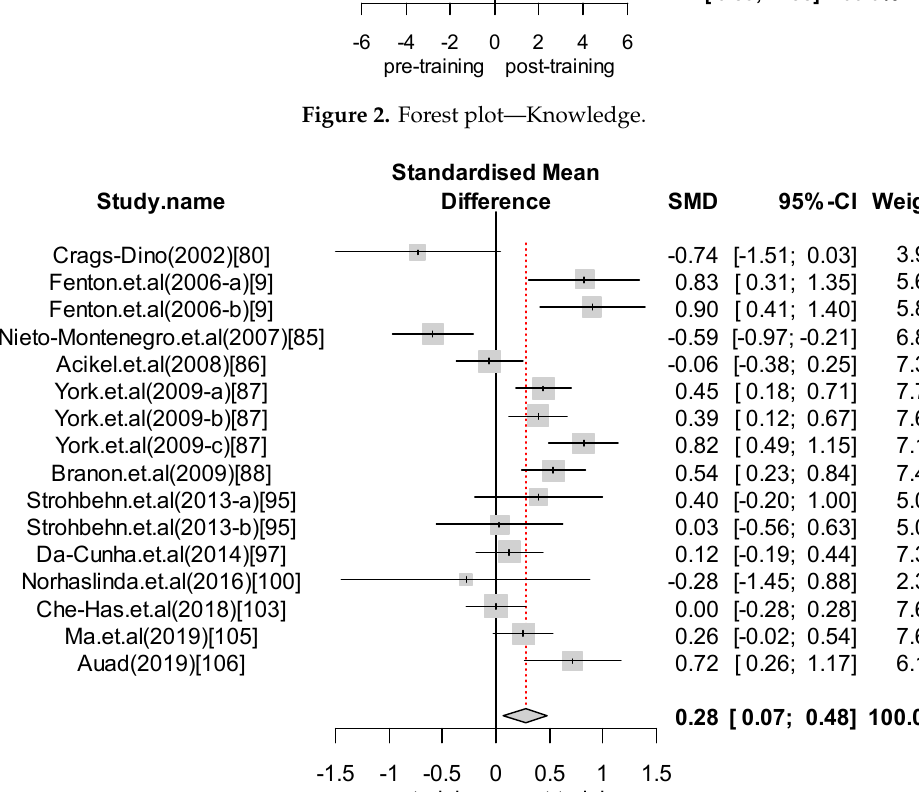
Figure 4. Forest plot—Overall practice.